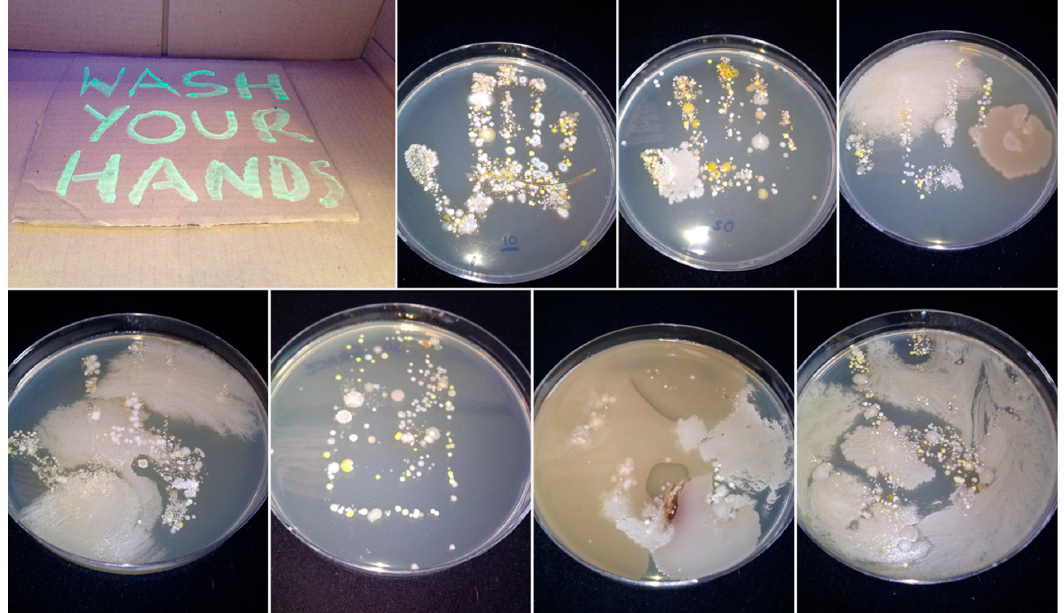
Figure 2. Example of the images uploaded to the Flickr page following the ‘Now Wash Your Hands’ event. Each image represents the handprint of one participant, revealing the range of microorganisms present on the hand.